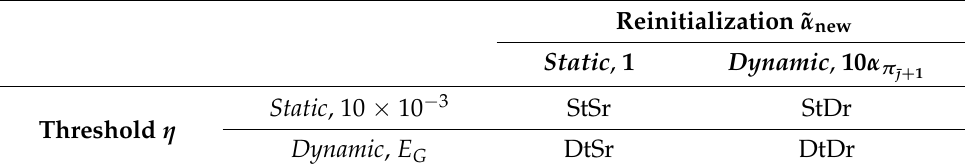
Table 3. MF-CS-DFN setups: steplength threshold and reinitialization values.